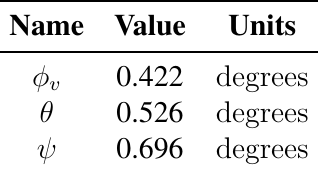
Table 6. Root mean square error for coupled EKF attitude estimates.